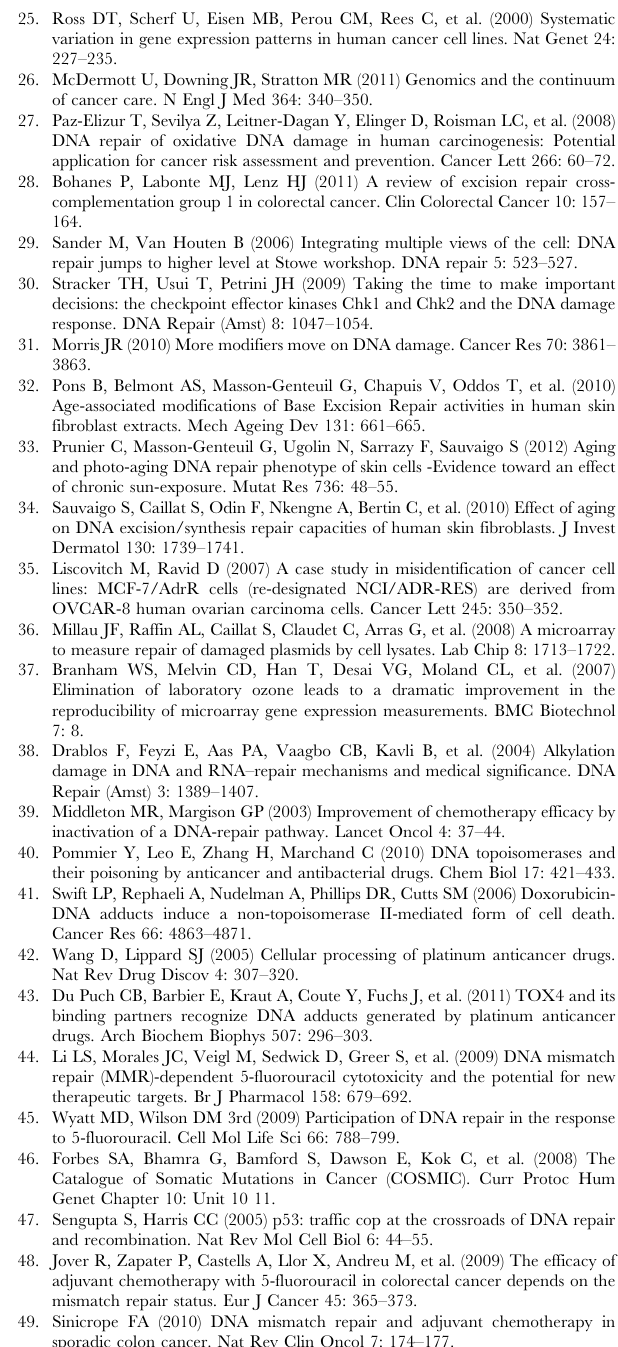
Table S2 IC20 expressed in molar concentration determined by MTS